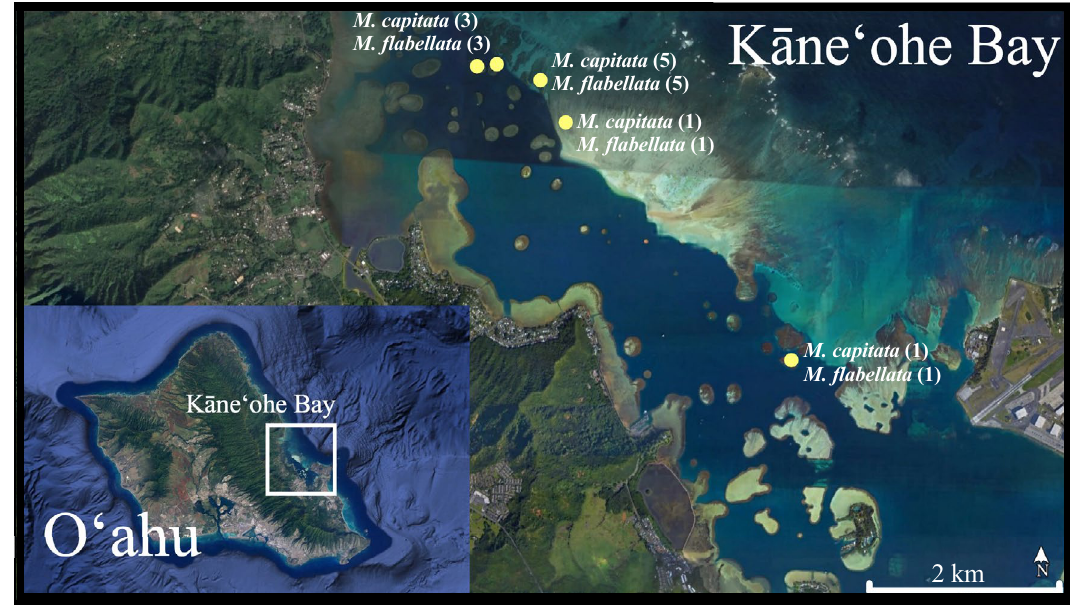
Figure 1. Map of coral collection sites in Kāne ʻ ohe Bay, O ʻ ahu, Hawai ʻ i. Map shows the locations and number of colonies per species used for histological sampling, with each M . flabellata colony paired to a nearby M. capitata colony at the same depth. Additional colonies used for spawning observations were later collected in the same areas. All corals were located at depths between 1 and 4 m. (Google Earth Pro v. 7.3.3.7786, www. earth. google.